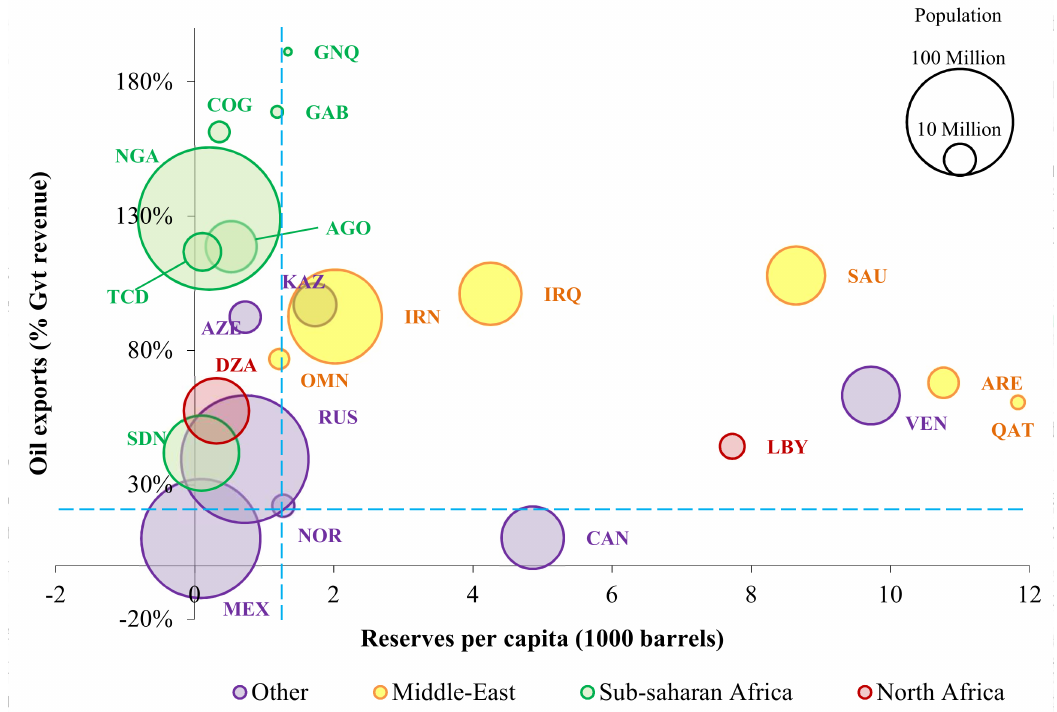
Figure 6. Exposure of state: oil exports vs. state budget (2014). Note: The dotted lines are centered on Norway (NOR). Data: [19,21,25,26]. Kuwait (KWT) is not shown because it has very high reserves per capita (27,000 bl, oil exports ~70% government